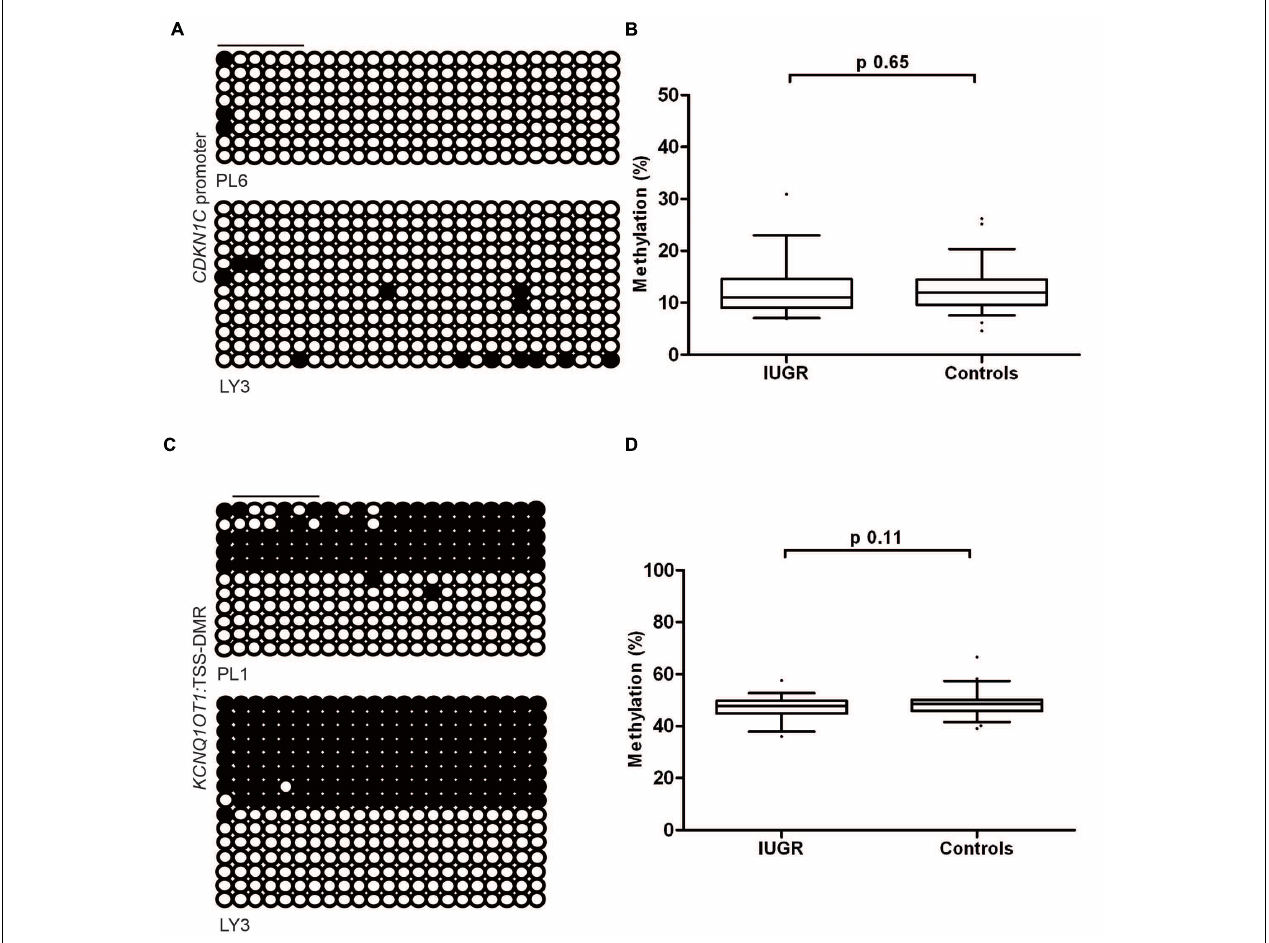
FIGURE 4 | The methylation profiles of the CDKN1C promoter and KCNQ1OT1 :TSS-DMR. (A) The left panels show an example of the placental and leukocyte methylation profiles of the 31 CpG dinucleotides analyzed within the CDKN1C promoter CpG island as determined by cloning and direct sequencing. (B) The methylation profiles, representing the average methylation of the six CpGs assayed by pyrosequencing within the CDKN1C promoter. (C) The bisulfite PCR profiling for the 22 CpG dinucleotides analyzed in the KCNQ1OT1: TSS-DMR and (D) the resulting methylation profile as determined by pyrosequencing. Each circle represents a CpG on the strand, and filled circles and open circles indicate methylated and unmethylated sites, respectively. Horizontal lines indicate the CpG sites analyzed by pyrosequencing. PL, placenta; LY,